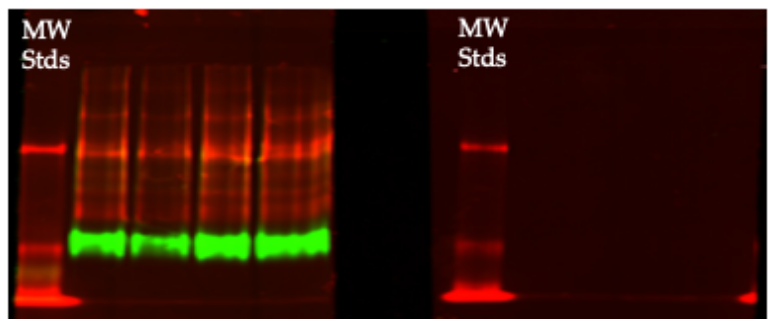
Figure 8. Native PAGE separation of apo (red) and holo (green) ceruloplasmin of rat plasma detected on immunoblots by two separate primary antibodies: against human (green fluorescence; Dako) and rat ceruloplasmins (red fluorescence, in-house) produced in rabbits and goats, respectively, with fluorescent secondary antibodies (donkey anti-rabbit and anti-goat) from Li-COR. Molecular weight standards (MW Stds; upper and lower red bands) were 130 and 100 kDa, but cannot determine molecular weight of the substituents, because this is non-denaturing PAGE where separation depends upon the inherent charge, mass and shape of a protein. Samples are from 4 different rats [33].